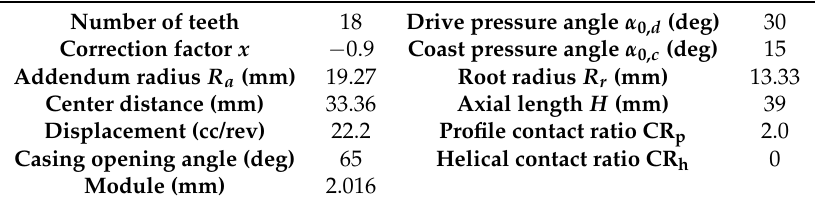
Table 1. Specifications for the gear pump taken as reference in this